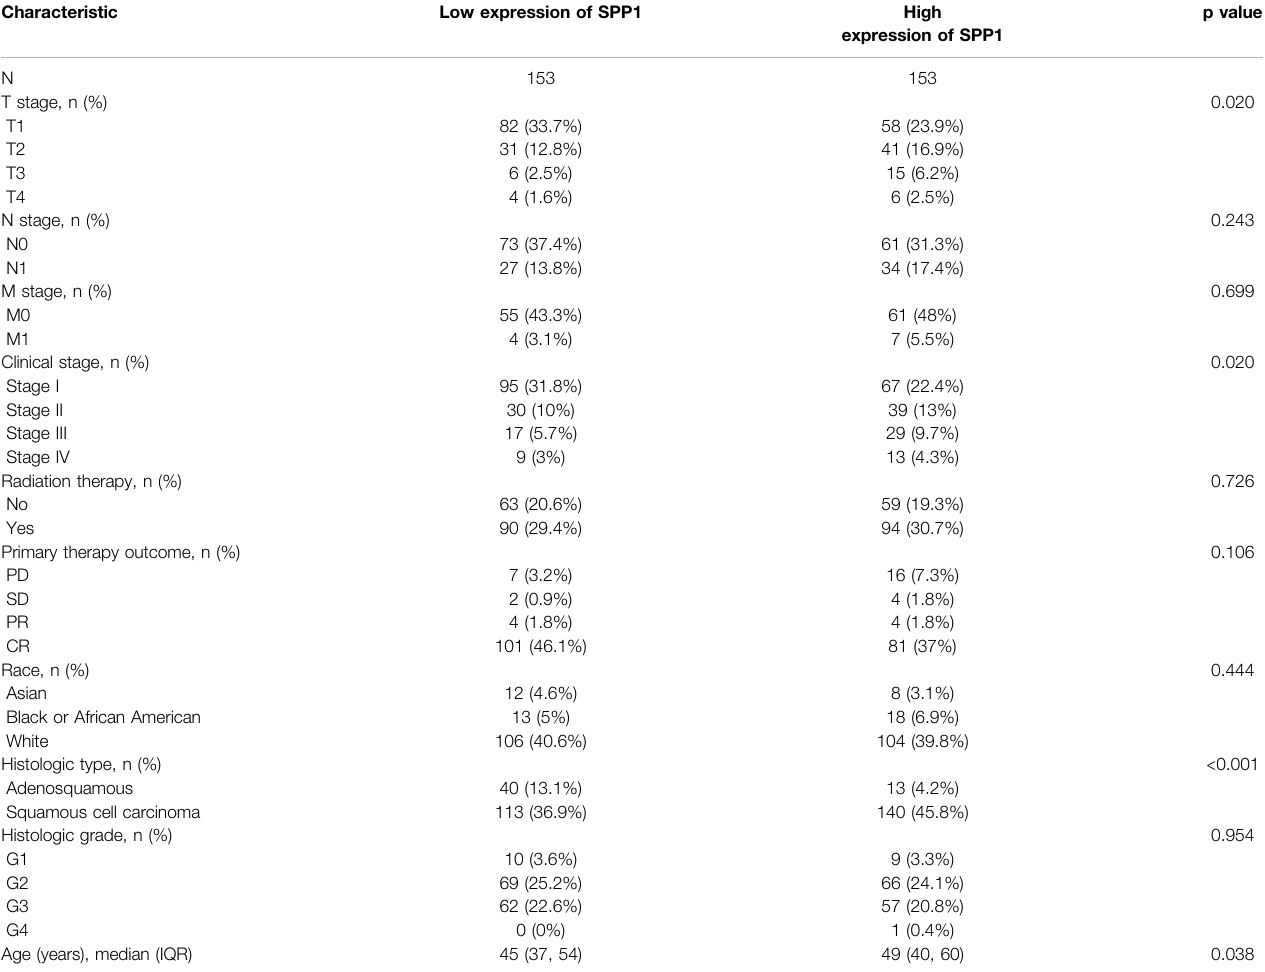
TABLE 1 | Correlation analyzed between SPP1 expression and clinicopathologic characteristics in cervical cancer based on TCGA database.